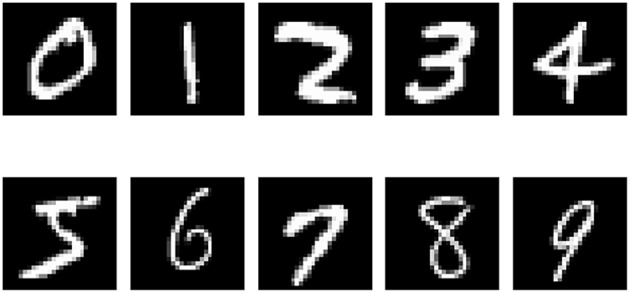
Input Image Set S.